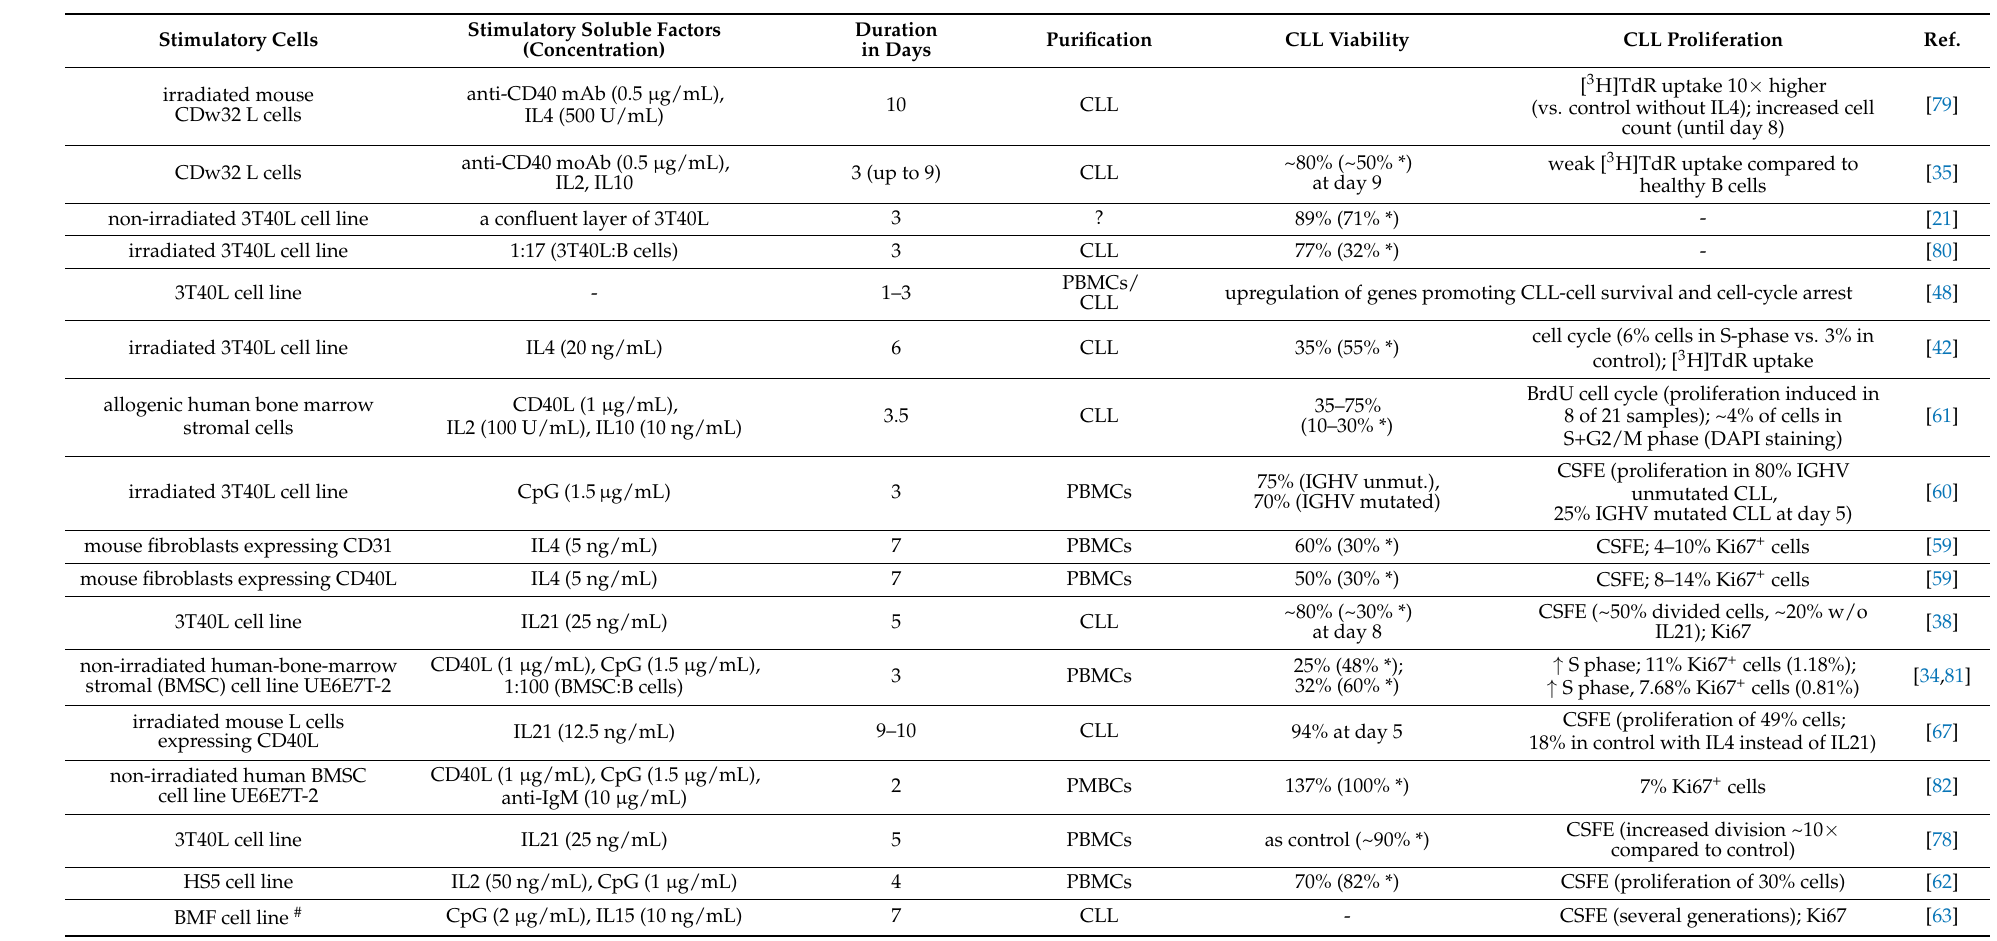
Table 2. In vitro models utilizing co-culture of CLL cells with engineered supportive cell lines and soluble factors.